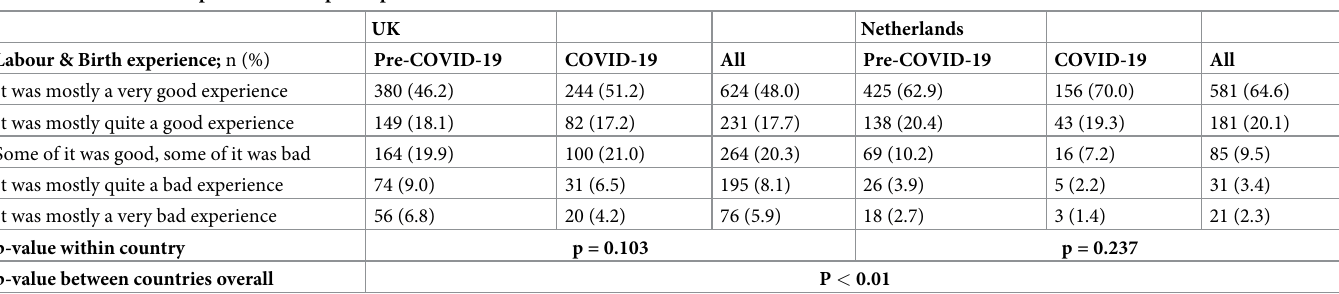
Table 5. Overall birth experience of the participants.